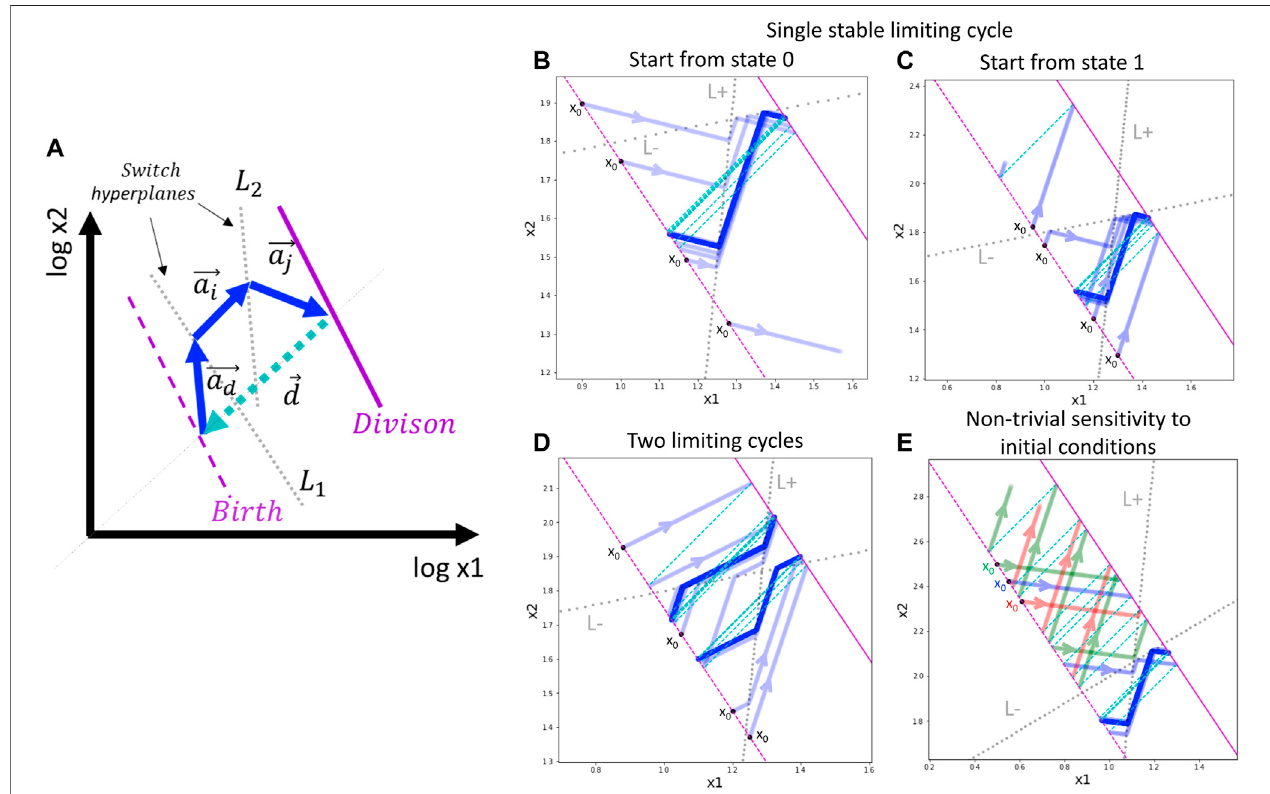
FIGURE 2 | General schema of switch-like dynamics and application to a toy model with a single trigger. (A) Schematic two-dimensional example of a limiting trajectory with division. The division hyperplane D is shown in purple, solid line. The birth hyperplane B is obtained from D by translation at vector d , shown in cyan (the most natural is to assume all the components of d to be – log 2). Two switch hyperplanes L 1 and L 2 are shown by dotted grey lines. The limiting cycling trajectory is representedbyblue arrows. (B,C) Exampleofsinglelimitingcycleintheswitchingdynamics.Dependingontheinitialstateoftheautomatonandtheinitialposition, the trajectory enters into the limit cycle or degenerates (goes to in fi nity). For the same parameters, four initial conditions are shown. The trajectory is plotted with semi- transparent blue color such that the intense blue line designates the trajectory cycling multiple times on top of itself. (D) Example of existence of two limit cycles. Depending on the initial state and position, the automaton ends up in one of the two possible limit cycles. (E) Example of non-trivial dependence of the switching dynamics on the initial position of the automaton. The trajectories drawn by different colors from three closely located initial positions are shown, with two leading to degenerateddynamicsandonelocatedinbetweenthe fi rsttwo,leadingtothelimitcycle.In(B – E)panels,theinitialpositionoftheautomatonisalwaysshownatthebirth hyperplane B (shown by dashed purple line), therefore, it is characterized by a single